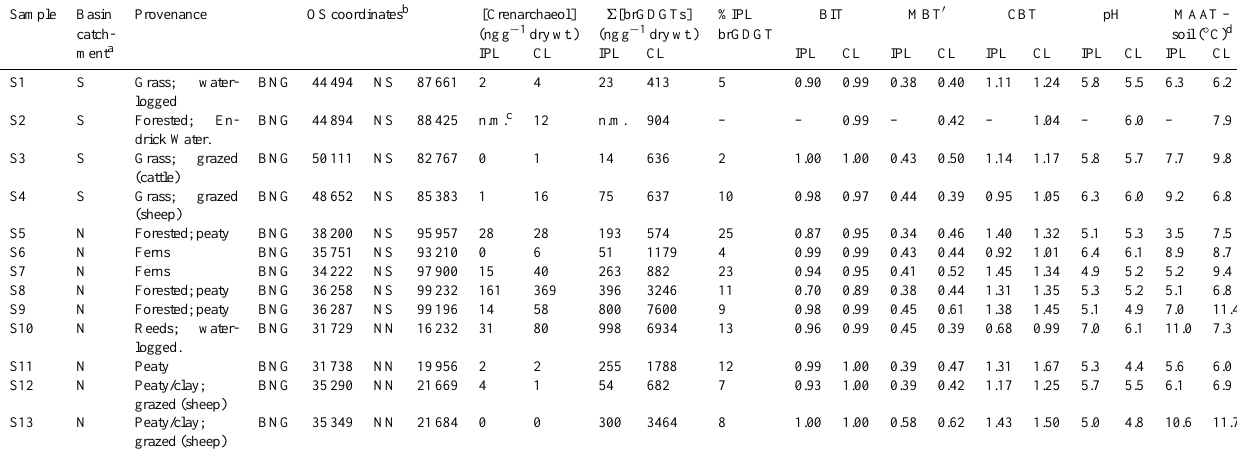
Table 1. Locations and provenance of soils, in conjunction with crenarchaeol concentrations and summed brGDGT concentrations, BIT indices, MBT 0 indices, CBT ratios, inferred pH and inferred mean annual air temperatures (MAATs). Sample Basin Provenance OS coordinates